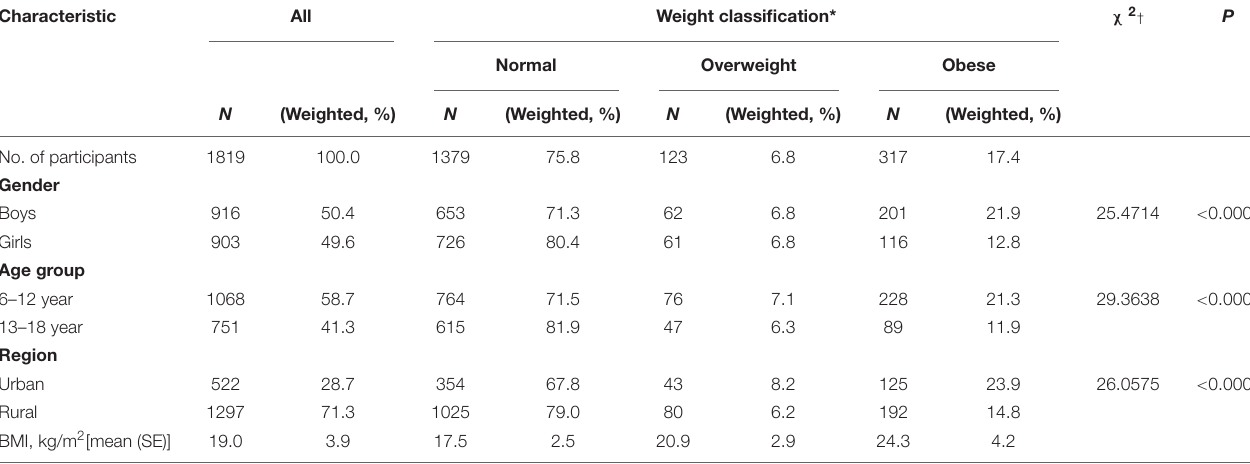
TABLE 1 | Characteristics of study subjects and their associations with weight status among 6–18 years in Shandong, China. Characteristic All Weight classification* χ 2 † P Normal Overweight Obese